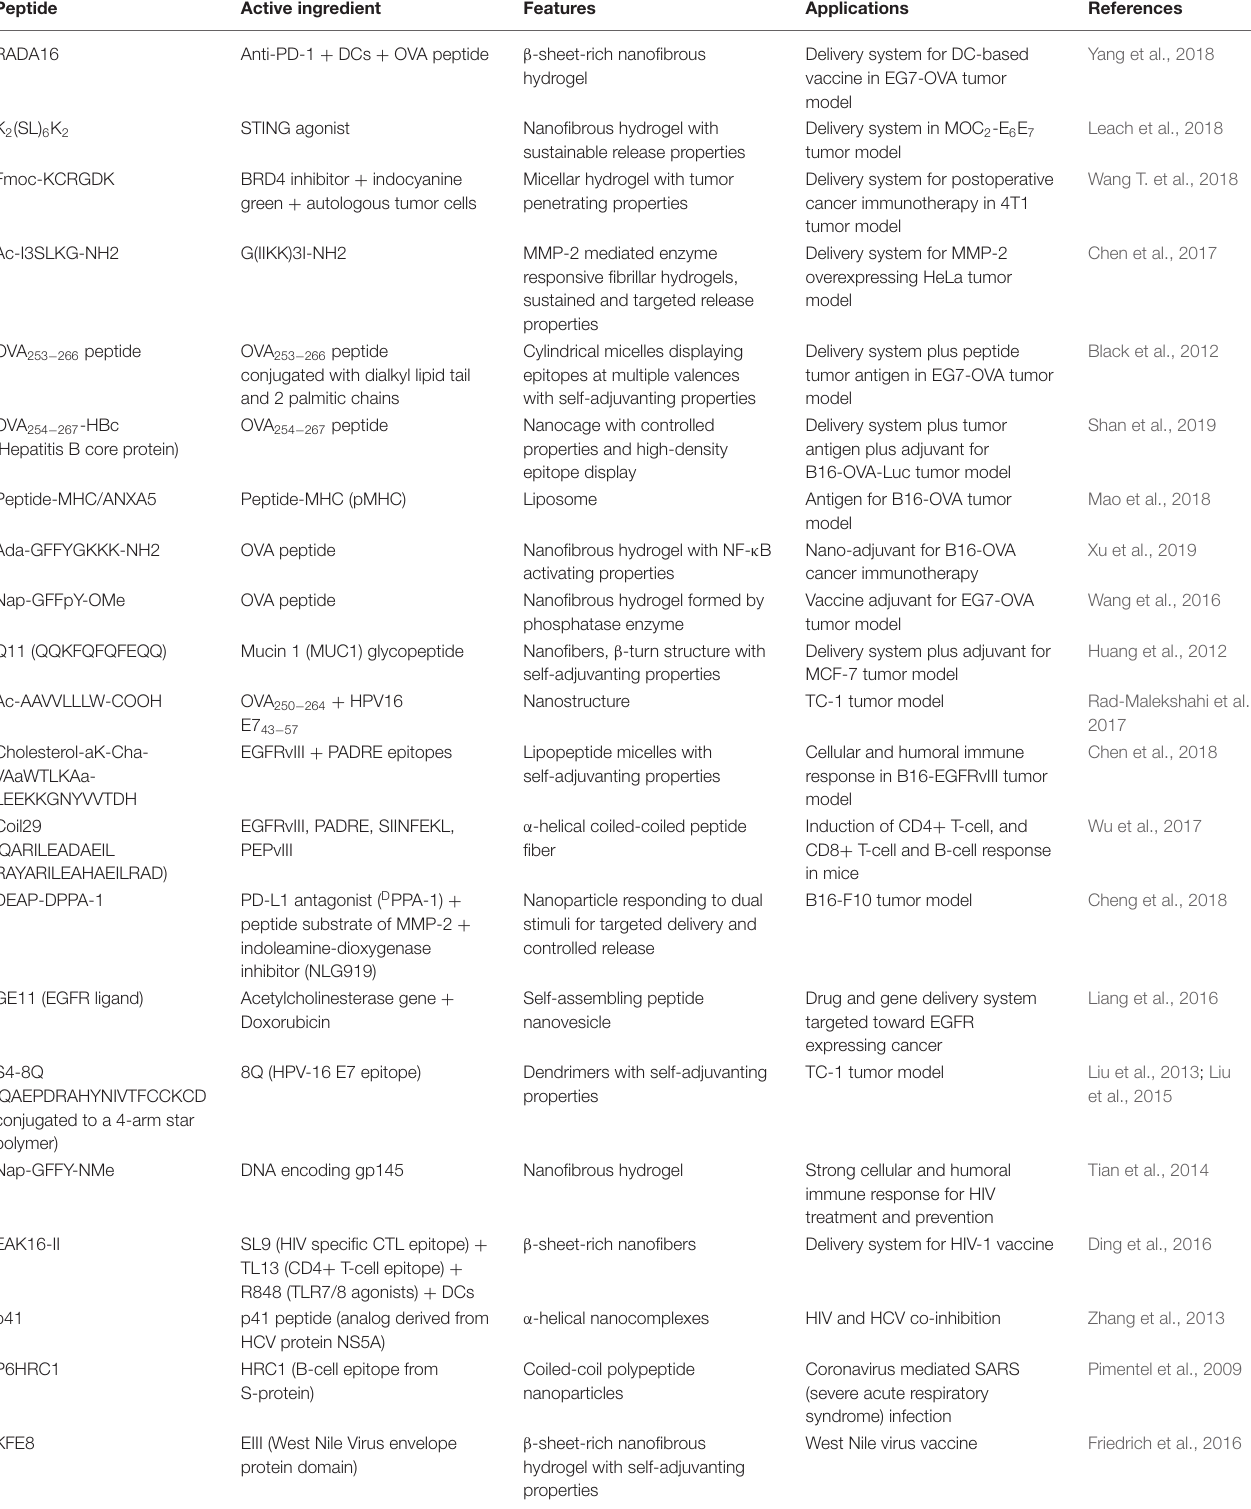
TABLE 1 | Summary of supramolecular peptide-based vaccines for cancer and infectious diseases.